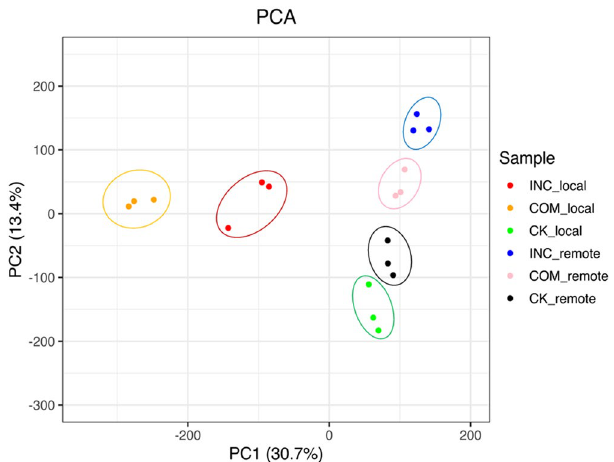
Figure 2. Principal component analysis (PCA) based on expressed genes across all samples. X-axis, PC1; Y-axis, PC2. The proportion of variance for each principal component is indicated in brackets following axis titles. Treatments are designated as compatible (COM, susceptible), incompatible (INC, resistant) and mock (CK) in local, inoculated (local) and remote, non-inoculated (remote) cotyledon tissues. Dots in the same color are replicates of same